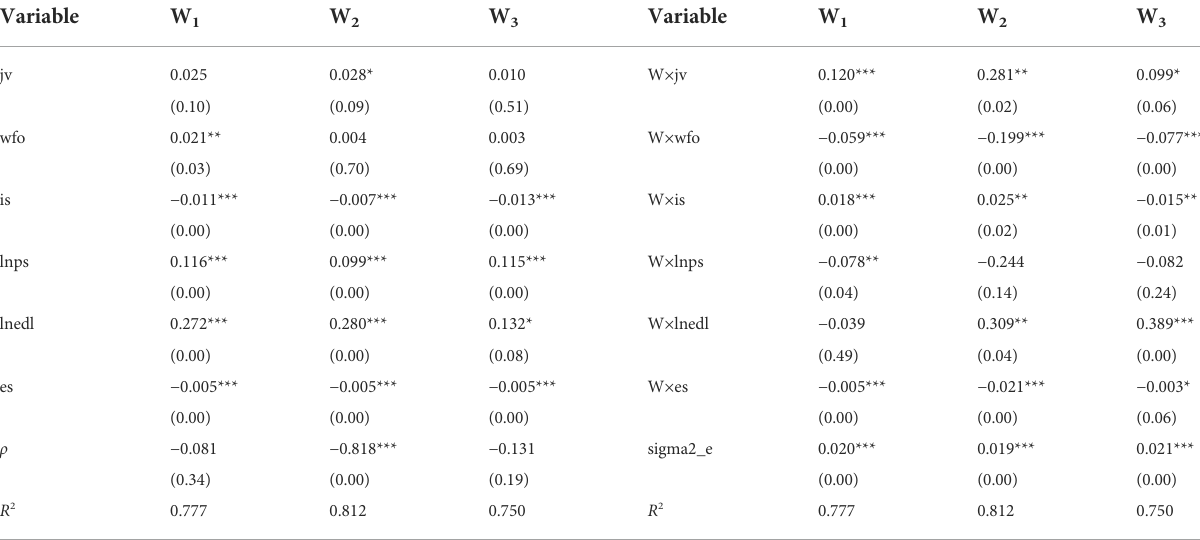
TABLE 7 Robustness